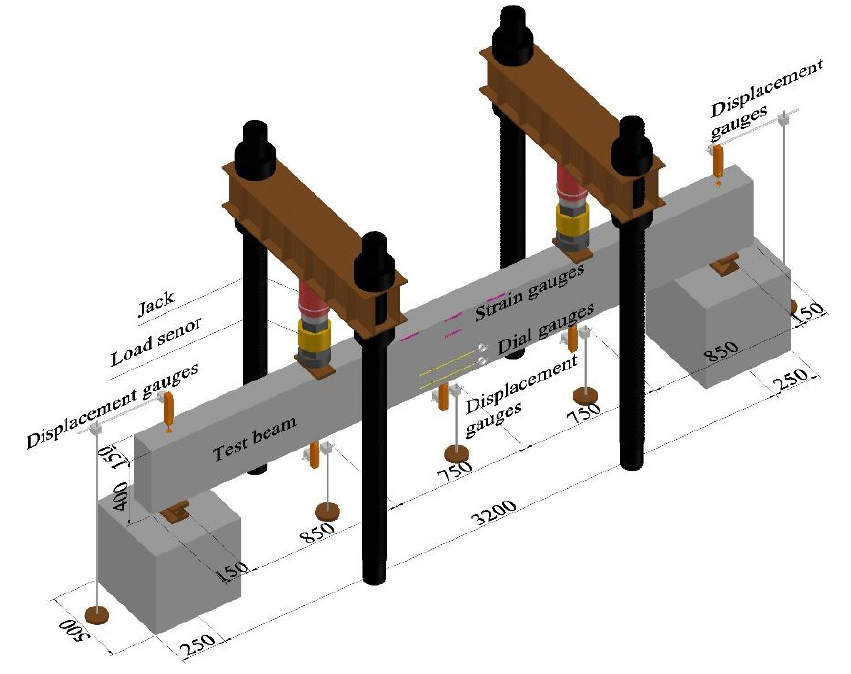
Figure 2. Test loading device and arrangement of measurements (Unit: mm).